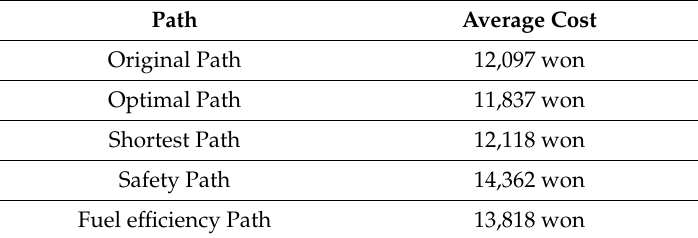
Table 8. Average cost analysis.